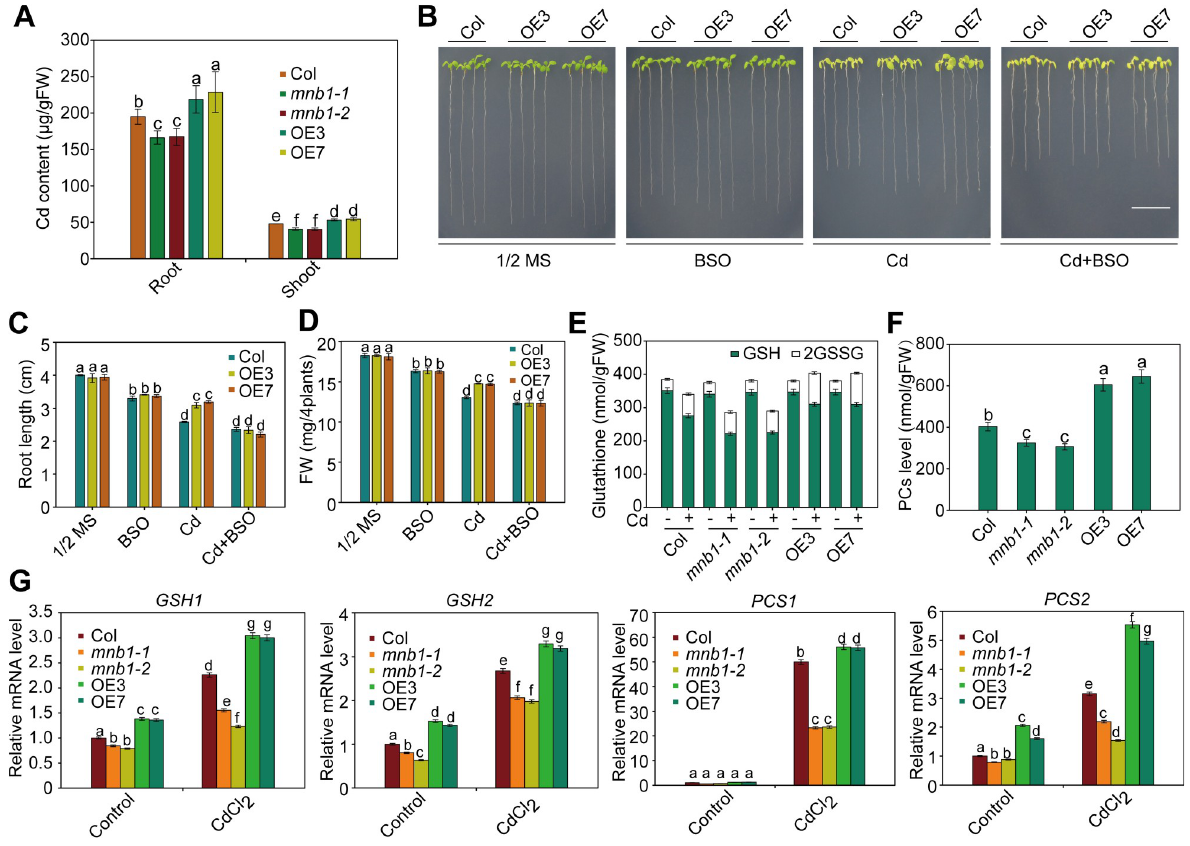
Fig 2. MNB1 gene positively regulates Cd tolerance by activating expression of PC synthesis-related genes. (A) Cd contents in roots and shoots of Col, mnb1 mutants, MNB1-OE lines. Plants were grown on 1/2 MS medium with 50 μ M CdCl 2 for 2 weeks for analysis of Cd content. Data are presented as means ± SD, n = 3. Bars with different lowercase letters are significantly different at P < 0.05 (Tukey’s test). (B) Effects of BSO in Col and MNB1-OE lines under Cd stress. Three-day-old plants grown on 1/2 MS medium were transferred to 1/2 MS medium with or without 50 μ M CdCl 2 and 0.1 mM BSO for 2 weeks. Scale bar = 1cm. (C, D) Root length (C) and fresh weight (D) of plants described in (B). Three independent experiments were done with similar results, each with three biological repeats. Four plants per genotype from one plate were measured for each repeat. Data are presented as means ± SD, n = 3. Bars with different lowercase letters are significantly different at P < 0.05 (Tukey’s test). (E, F) Total GSH content and total PC content in Col, mnb1 mutants and MNB1-OE plants in the absence or presence of Cd. Two-week-old plants grown on 1/2 MS medium were treated with or without 50 μ M CdCl 2 for 24 h for analysis of glutathione and PC contents. Data are presented as means ± SD, n = 3. Bars with different lowercase letters are significantly different at P < 0.05 (Tukey’s test). (G) Transcript levels of genes involved in the PC synthesis pathway in Col, mnb1 mutants and MNB1-OE plants in the absence or presence of Cd. GAPDH was used as an internal control. Two-week-old plants grown on 1/2 MS medium were treated with or without 50 μ M CdCl 2 for 6 h. Data are presented as means ± SD, n = 3. Bars with different lowercase letters are significantly different at P < 0.05 (Tukey’s